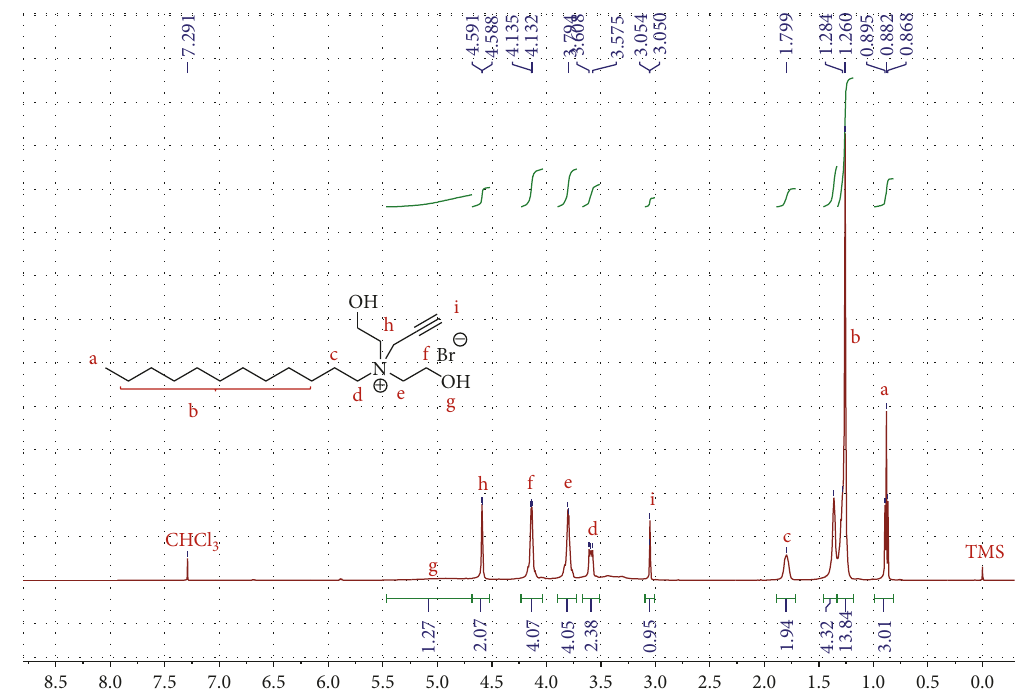
Figure 3: 1 H NMR spectrum of 2c